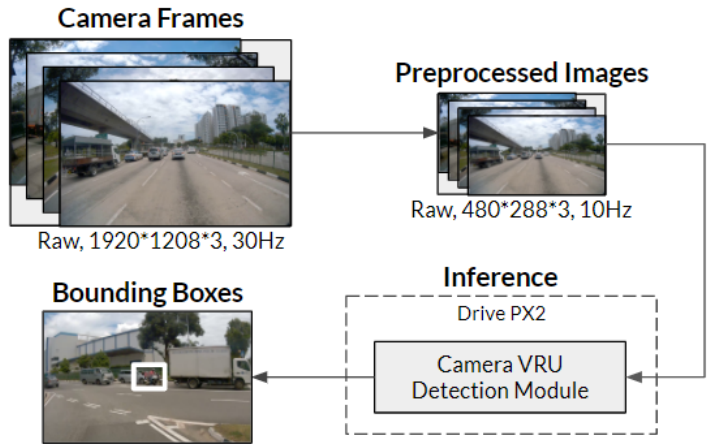
Figure 5. Overview of data pipeline for camera detection from the raw data to inference of vulnerable road users (VRUs) on the Nvidia Drive PX2 hardware.